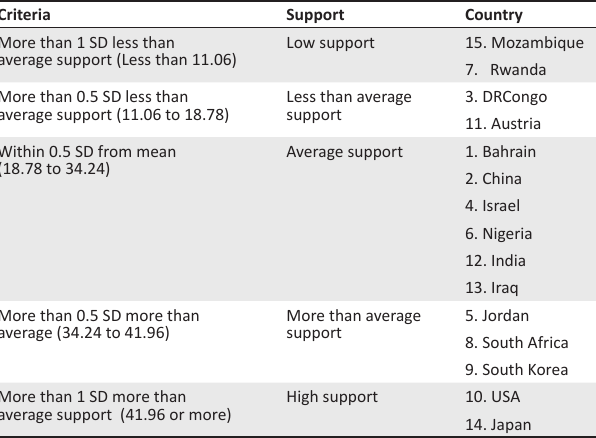
TABLE 4: Five levels of contextual support for nursing research . Criteria Support Country More than 1 SD less than average support (Less than